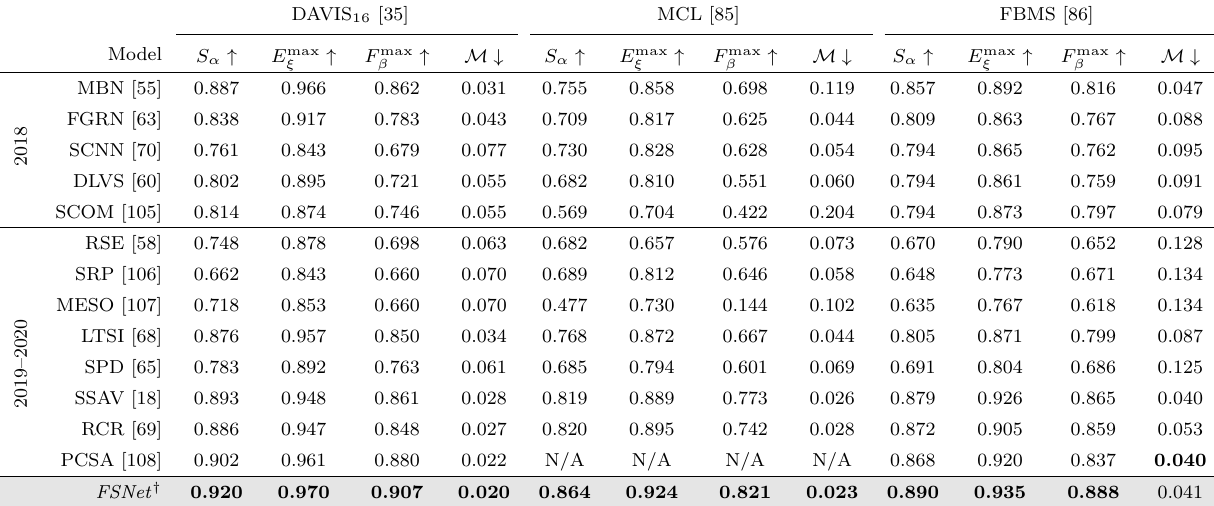
Table 2 Video salient object detection (V-SOD) results for our FSNet , compared to 13 state-of-the-art models on three popular V-SOD datasets, including DAVIS 16 [35], MCL [85], and FBMS [86]. † indicates that we generate non-binary saliency maps without CRF [84] to enable a fair comparison. N/A means results are not